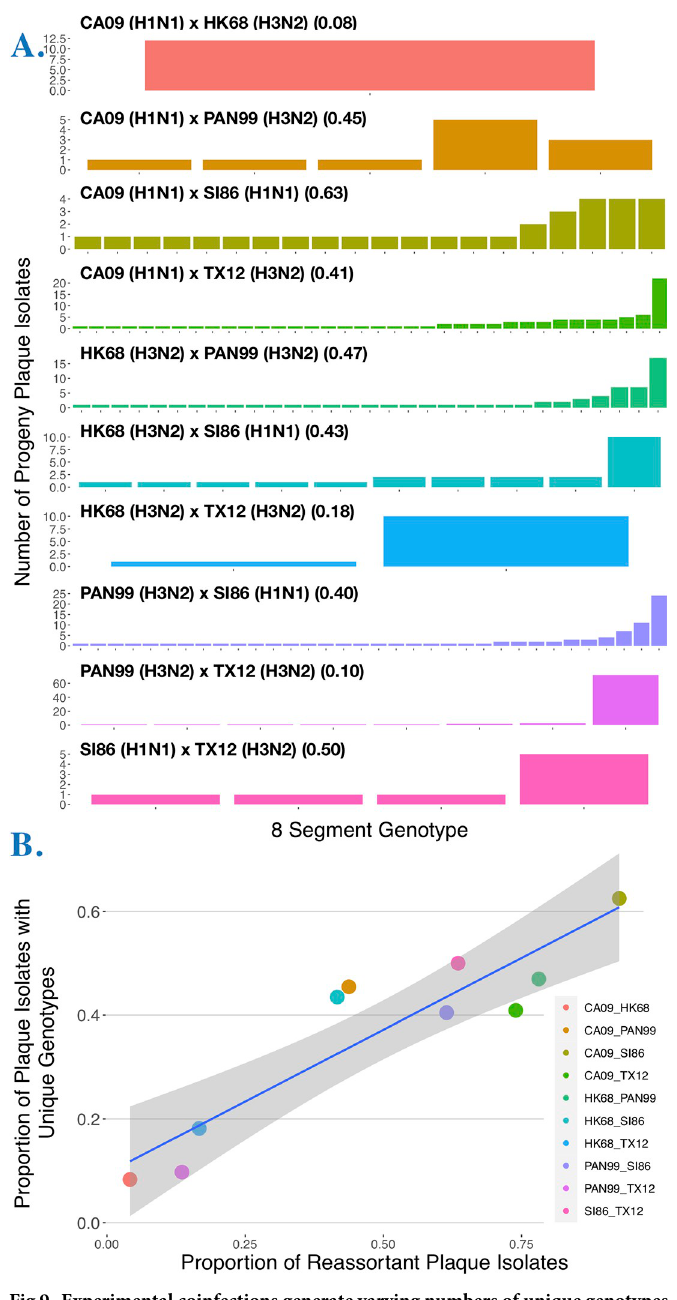
Fig 9. Experimental coinfections generate varying numbers of unique genotypes. A. The number of plaques having different 8 segment genotypes are depicted for each experimental coinfection. The reassortment frequency is noted in parentheses next to the strains involved in the coinfection. B. Reassortment frequency is positively correlated to the proportion of unique